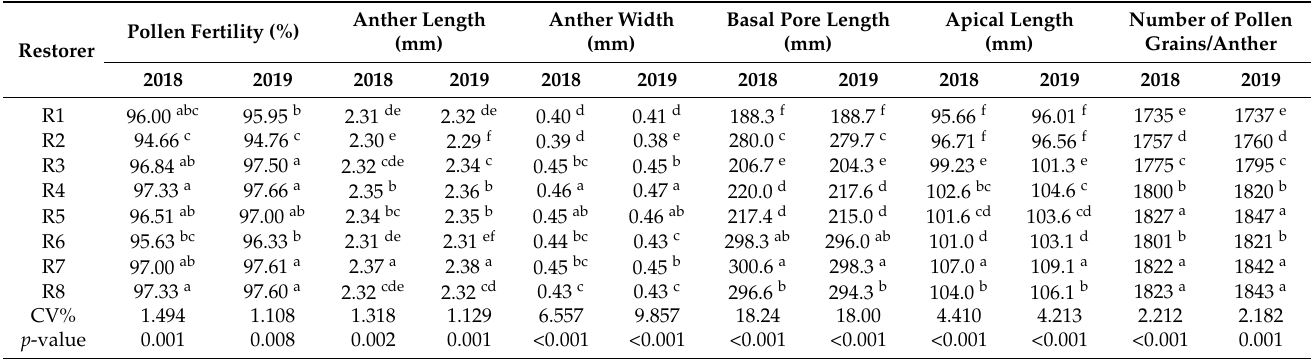
Table 2. Pollen ability of the restorer lines and their parental cultivars during the 2018 and 2019 growing seasons.